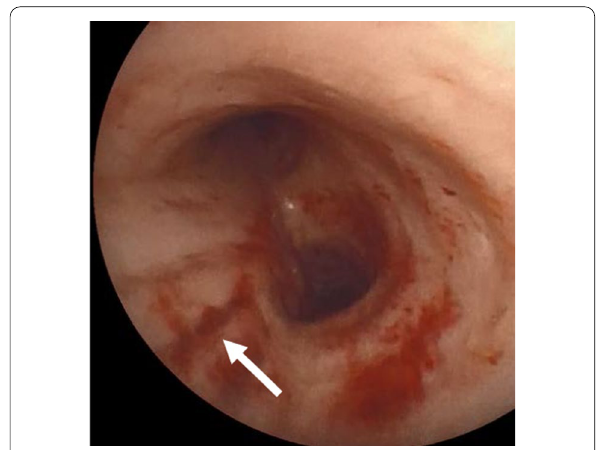
Fig. 2 Fiberoptic bronchoscopy revealed a longitudinal laceration on the membranous part of the distal trachea